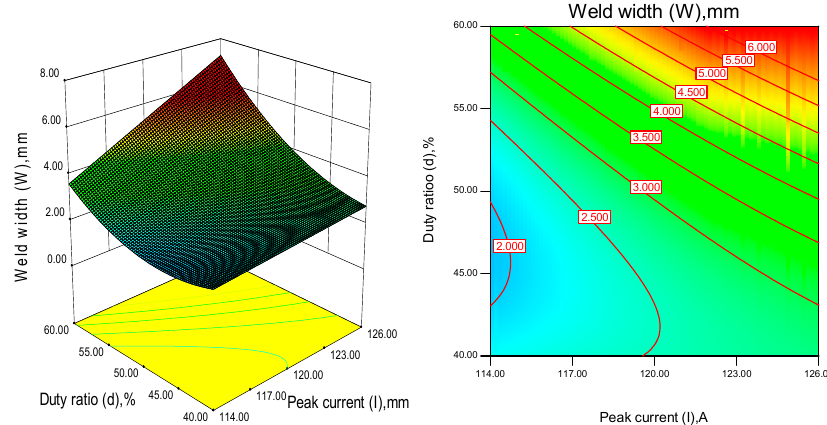
Figure 14. Interaction of peak current and duty ratio on weld width.